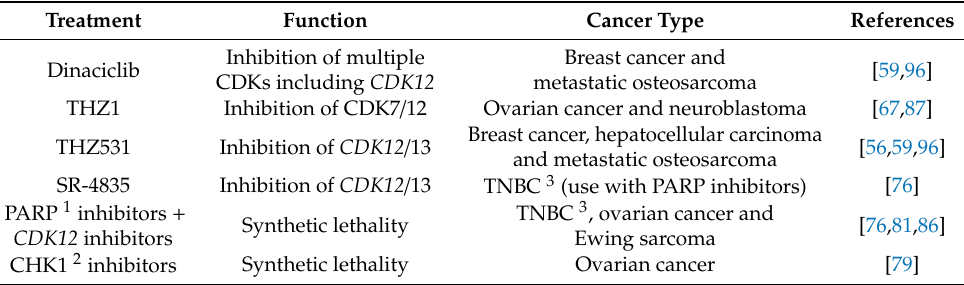
Table 2. CDK12 as potential target for cancer